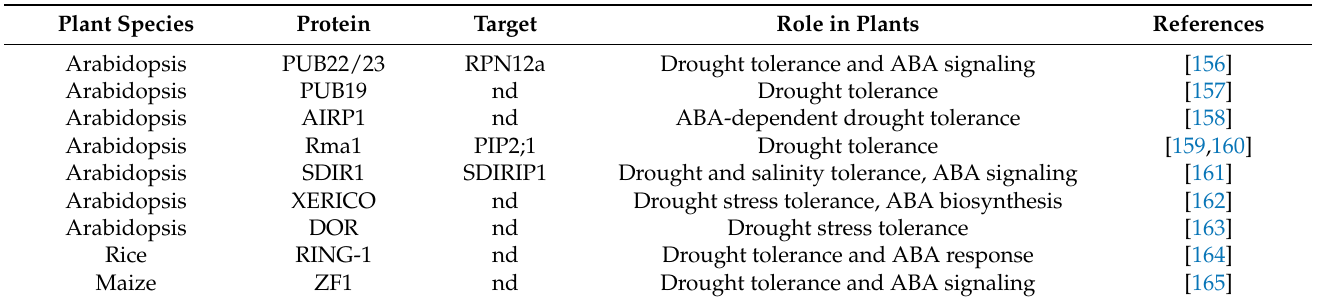
Table 2. Post-translational modifications and their predicted role in plants responsive to drought and ABA signaling in different plant